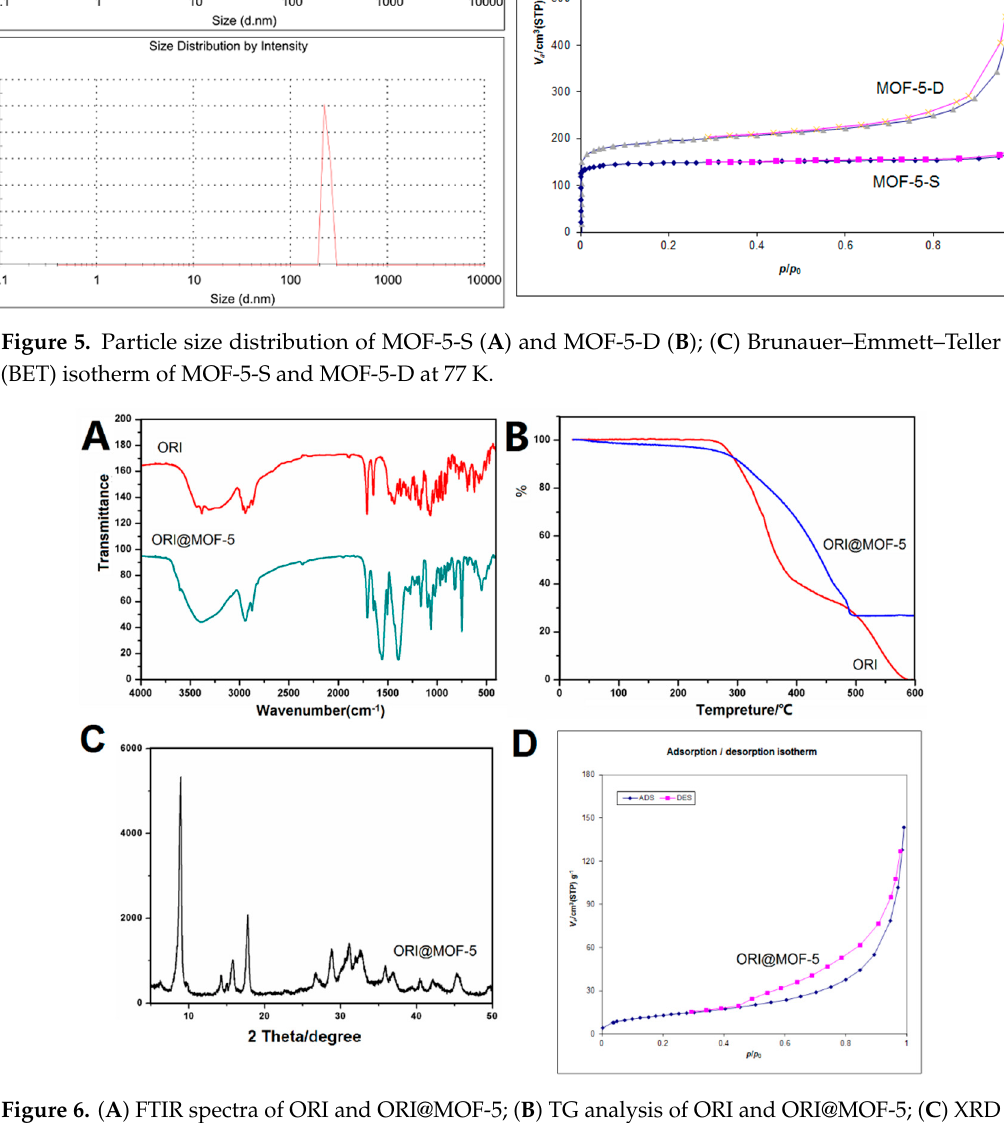
Figure 6. ( A ) FTIR spectra of ORI and ORI@MOF-5; ( B ) TG analysis of ORI and ORI@MOF-5; ( C ) XRD patterns of ORI@MOF-5; ( D ) BET isotherm of ORI@MOF-5.